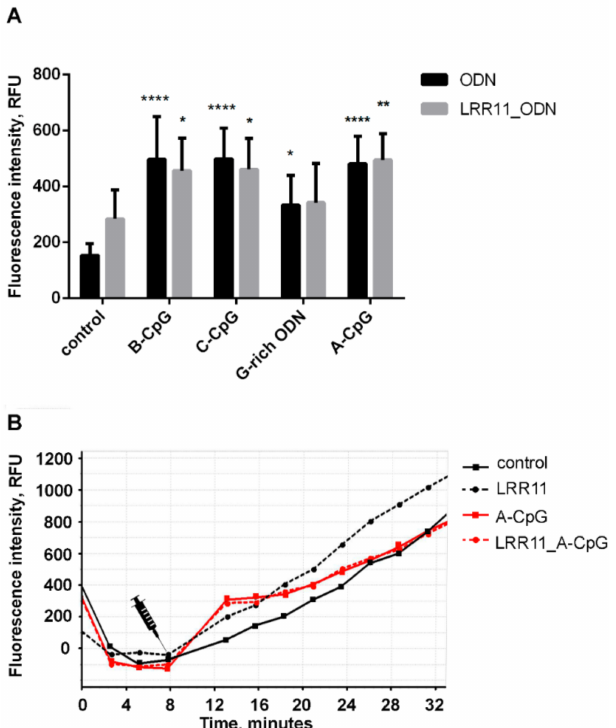
Figure 9. Effects of ODNs and LRR11 on intracellular concentration of free Ca 2+ in neutrophils. Fluo-3 AM-loaded neutrophils (1 × 10 6 /mL) were cultured in fibrinogen-coated flat bottom plates in HBSS/HEPES medium supplemented or not with 1 µ M LRR11, without additives or in the presence of 1 µ M ODNs, at 37 ◦ C, 5% CO 2 . Fluo-3 fluorescence signals (ex. 485 nm, em. 538 nm) were monitored with 2-min intervals. ( A ) Values represent the means ± SEM of fluorescence intensity increments in 7 min after the addition of stimulus ( n = 3). * p < 0.05, ** p < 0.01, **** p < 0.001 compared with the control, as indicated by two-way ANOVA followed by Sidak’s multiple comparison test. ( B ) Representative blank corrected Fluo-3 fluorescence kinetic curves for control (square, black solid line), LRR11 (circle, black dotted line), A-CpG (square, red solid line) and LRR11_A-CpG mix (circle, red dotted